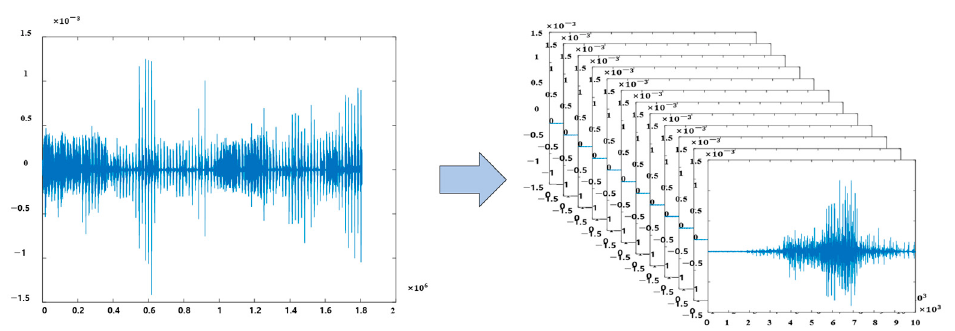
Figure 5. Partitioned one motion cycle signals.